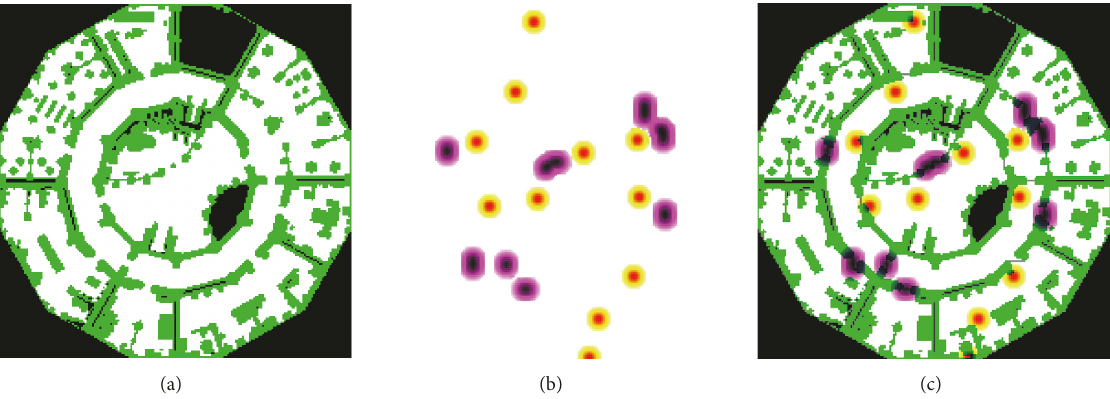
Figure 2: Representation of a grid-based game world: (a) game map; (b) influence map with attractors (in red-to-yellow) and repulsors (in dark lilac-to-light lilac); and (c) game map together with influence